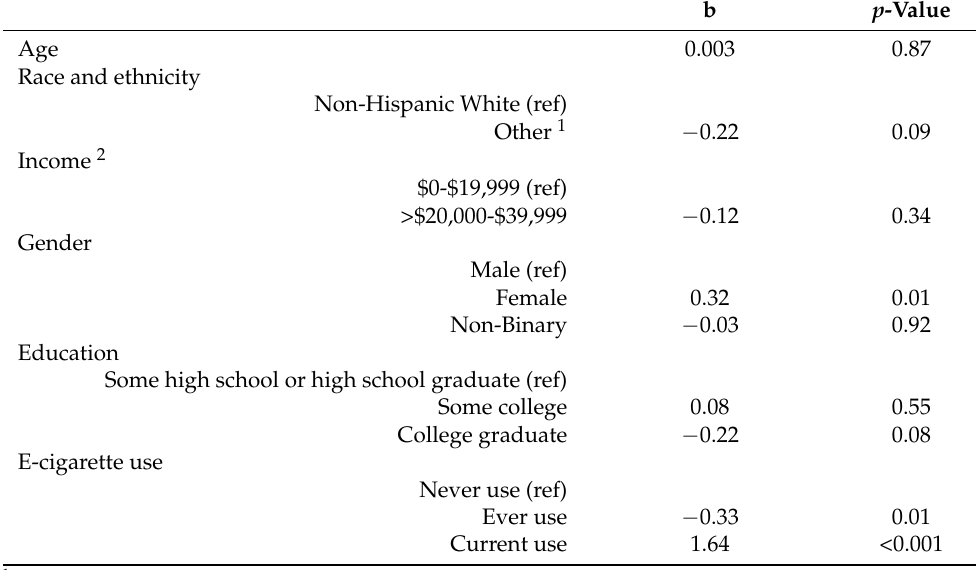
Table 3. Unadjusted associations of e-cigarette use intentions and demographics.